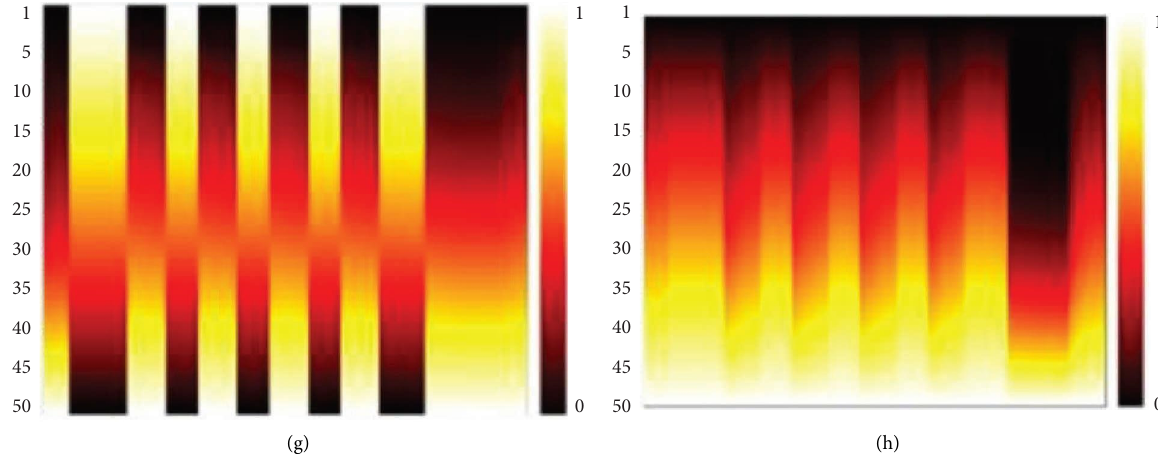
Figure 10: Typical tensor V consisting of NPP feld sensor signals generated by NPP simulation. (a–h) Class 1 ∼ 8.